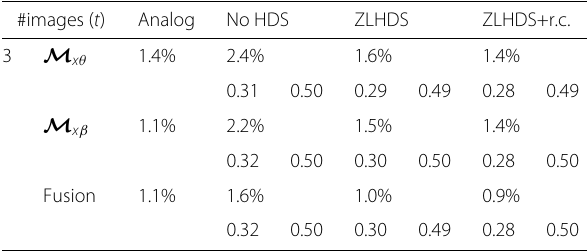
Table 3 EERs and BERs for the FVC2002